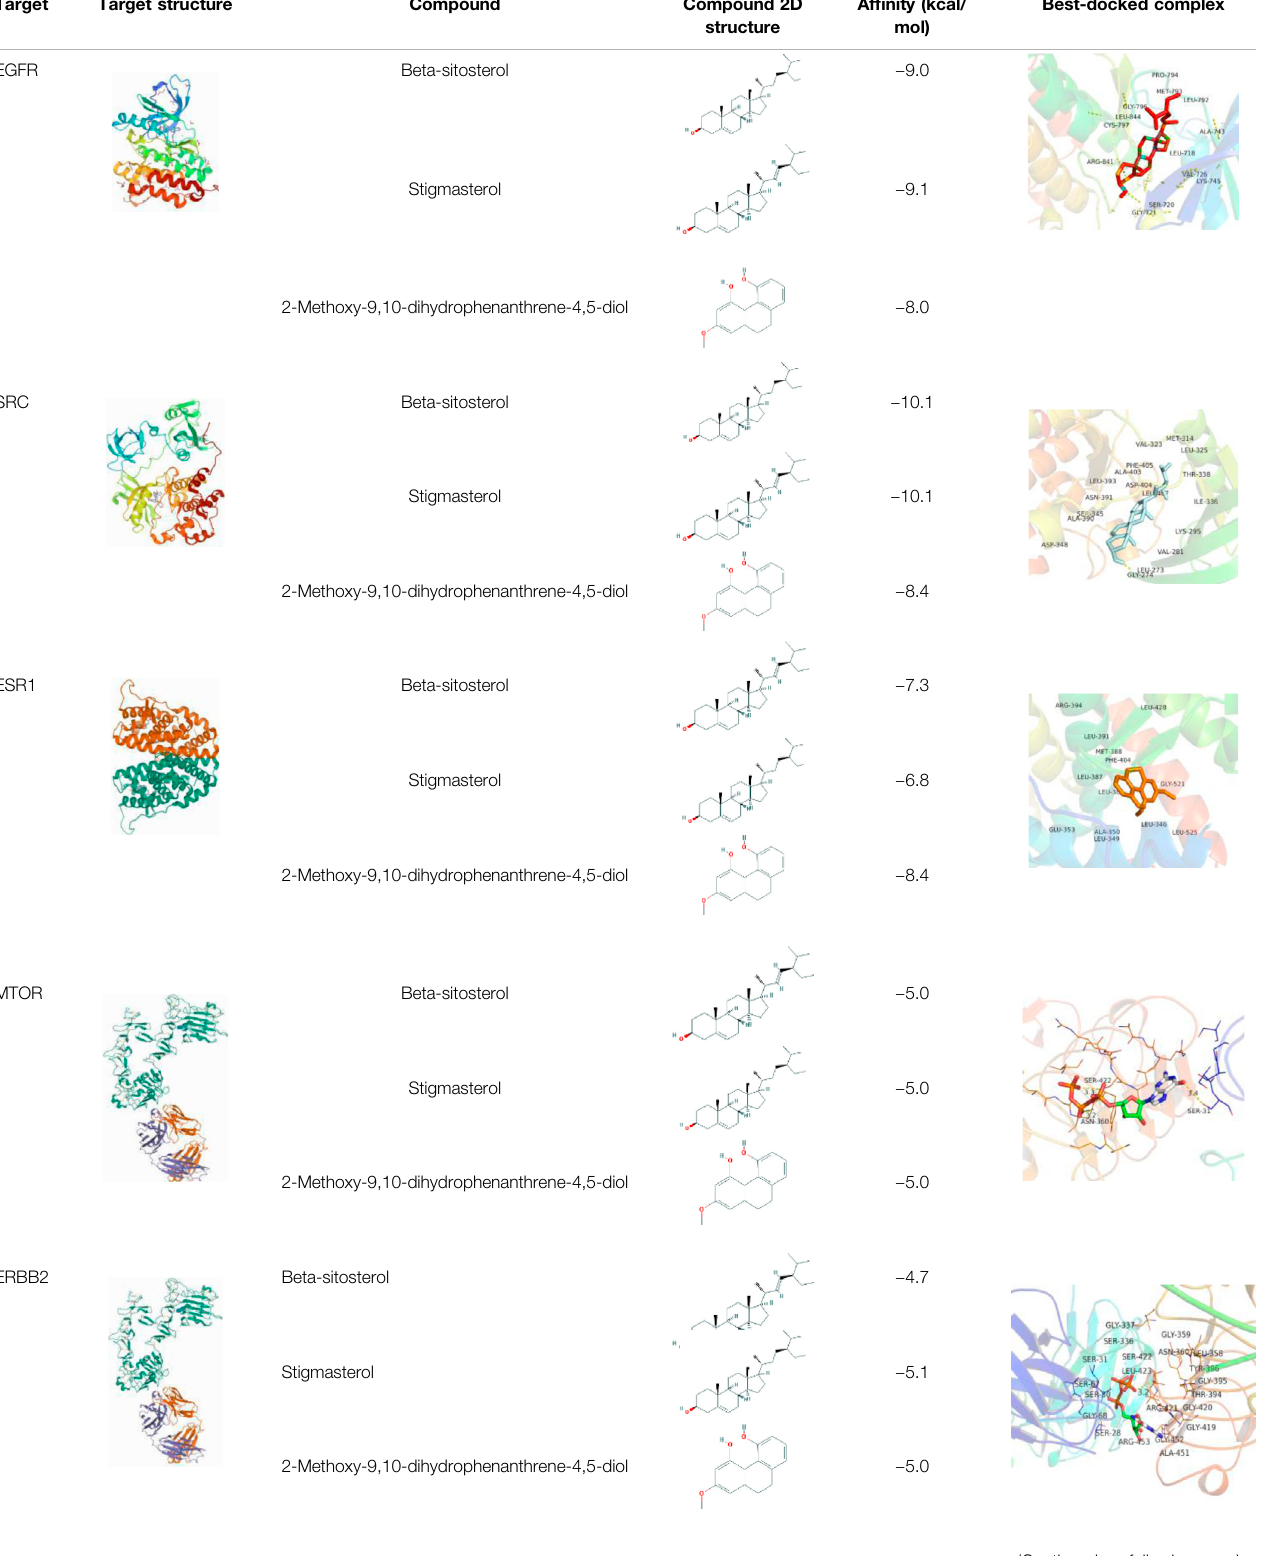
TABLE 3 | Molecular docking